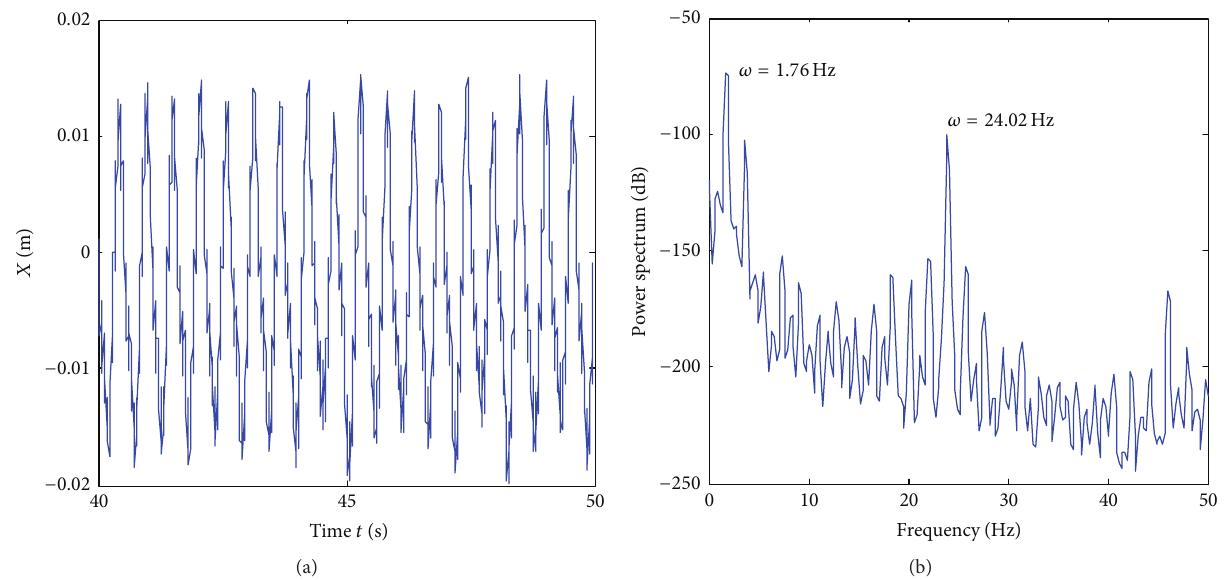
Figure 7: 𝑋 displacement when Ω = 24 Hz, ℎ 𝑐 = 0.1 m, 𝐹 pre = 100 N, 𝑐 𝑎 = 200 N and 𝜇 = 2 (a); power spectrum